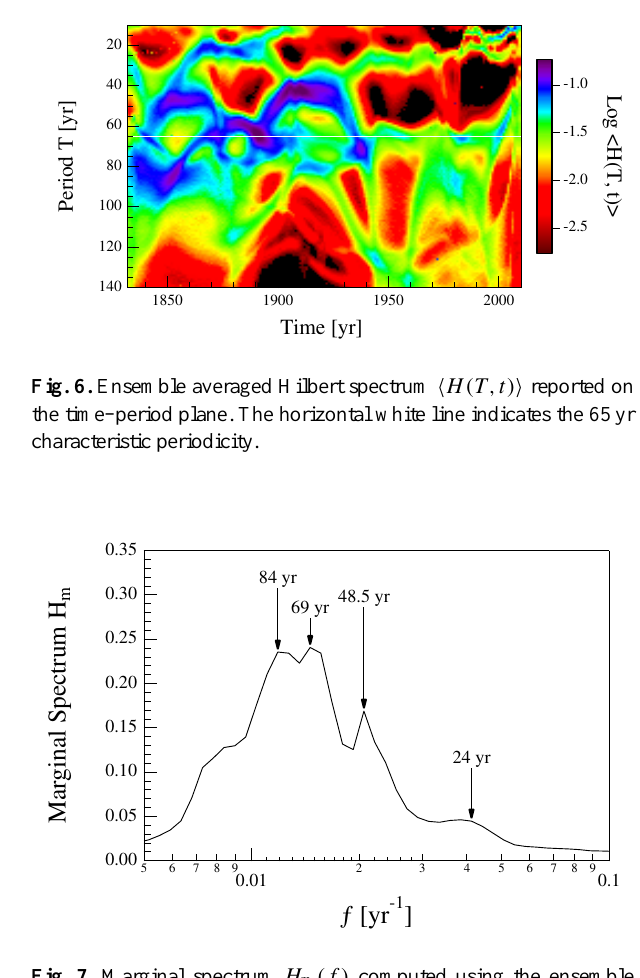
Fig. 7. Marginal spectrum H m ( f ) computed using the ensemble averaged Hilbert spectrum h H ( f,t ) i shown in Figure 5.